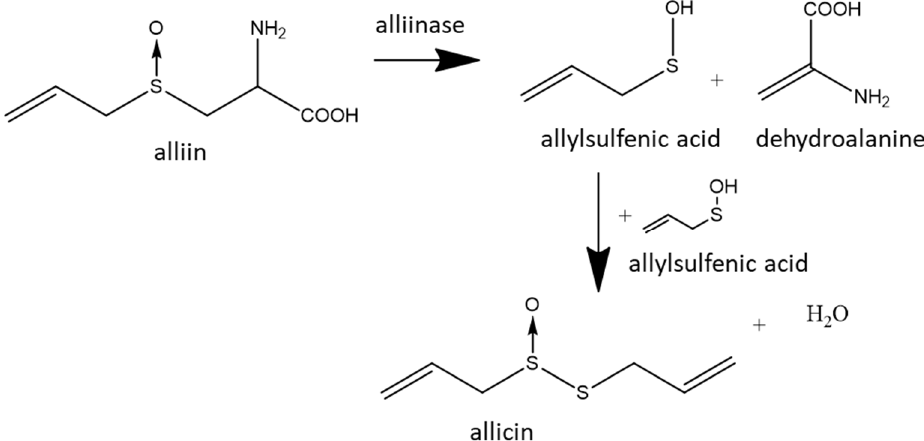
Figure 1. Enzymatic transformation of alliin to allicin by the enzyme alliinase which involves the conversion of alliin to intermediates allylsulfenic acid and dehydroalanine, followed by the condensation of two molecules of allylsulfenic acid to yield allicin.